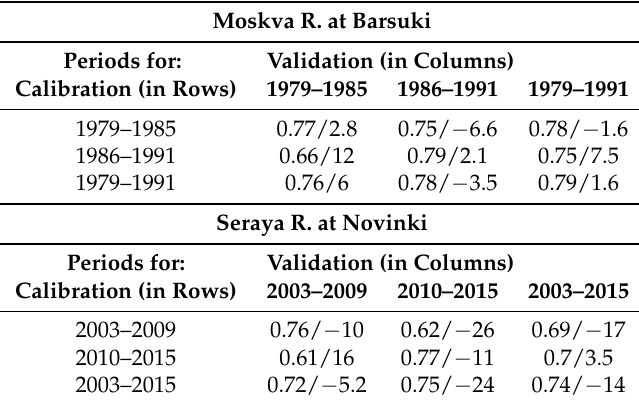
Table 2. Model performance summary for Moskva R. at Barsuki and Seraya R. at Novinki for different periods. The numerator and denominator values stand for NSE and Bias, respectively.